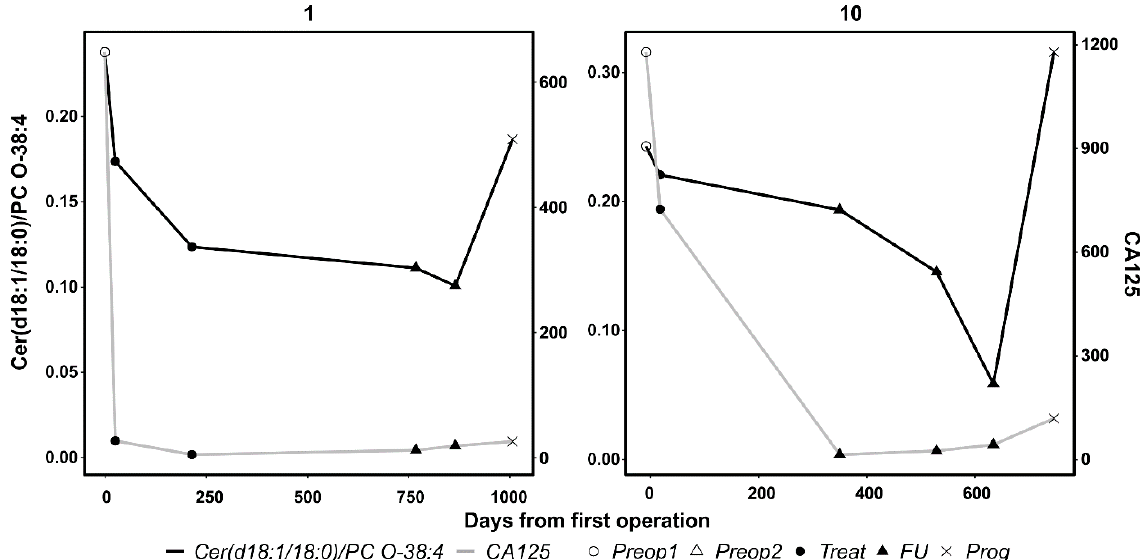
Figure 3. Longitudinal lipidomic and CA-125 analyses of two exemplified ovarian cancer patients. At progression, the two-lipid signature was strongly elevated whereas CA-125 showed none or minor elevation. Preop1, before first surgery; Preop2, before second surgery; Treat, on-treatment; FU, follow-up; Prog, progression.